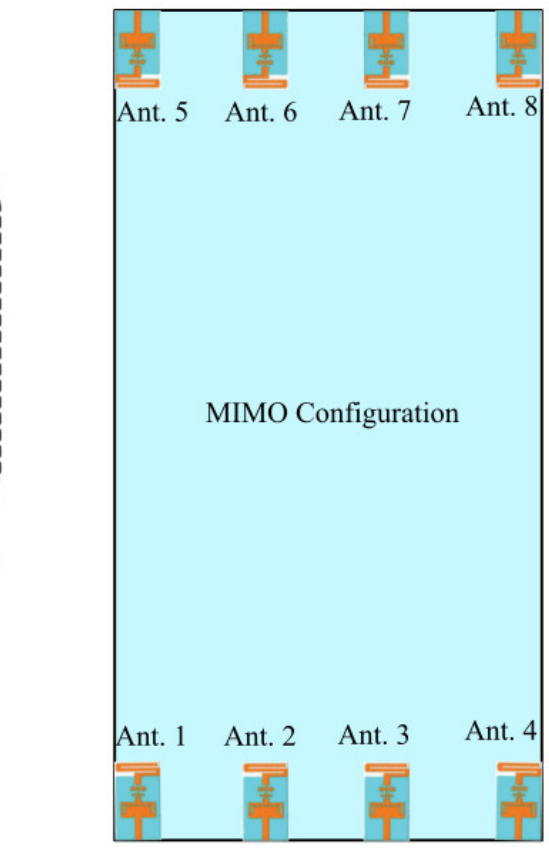
Figure 17. Structure of MIMO antenna that consists of 8 elements [98].